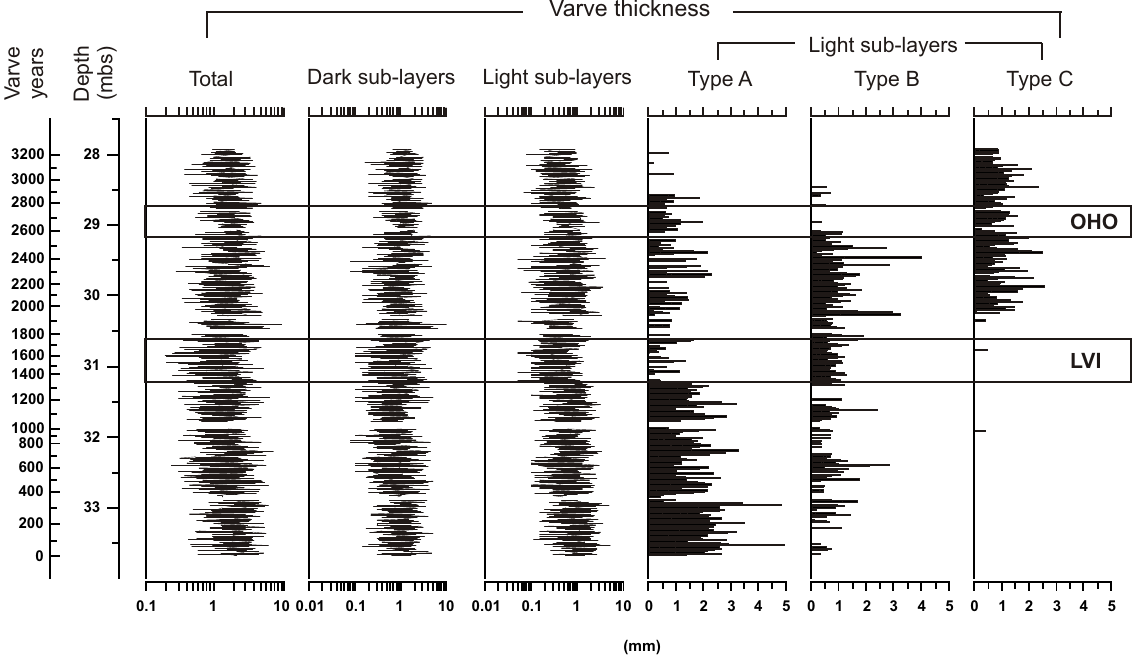
Fig. 4. Varve thickness measurements of dark sub-layers and different types of light sub-layers. Positions of the Older Holsteinian Oscillation (OHO) and the Low Variability Interval (LVI) are indicated.